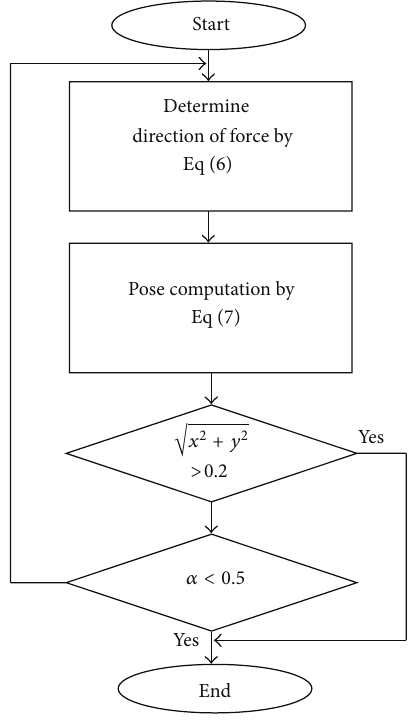
Figure 8: Flowchart of Algorithm